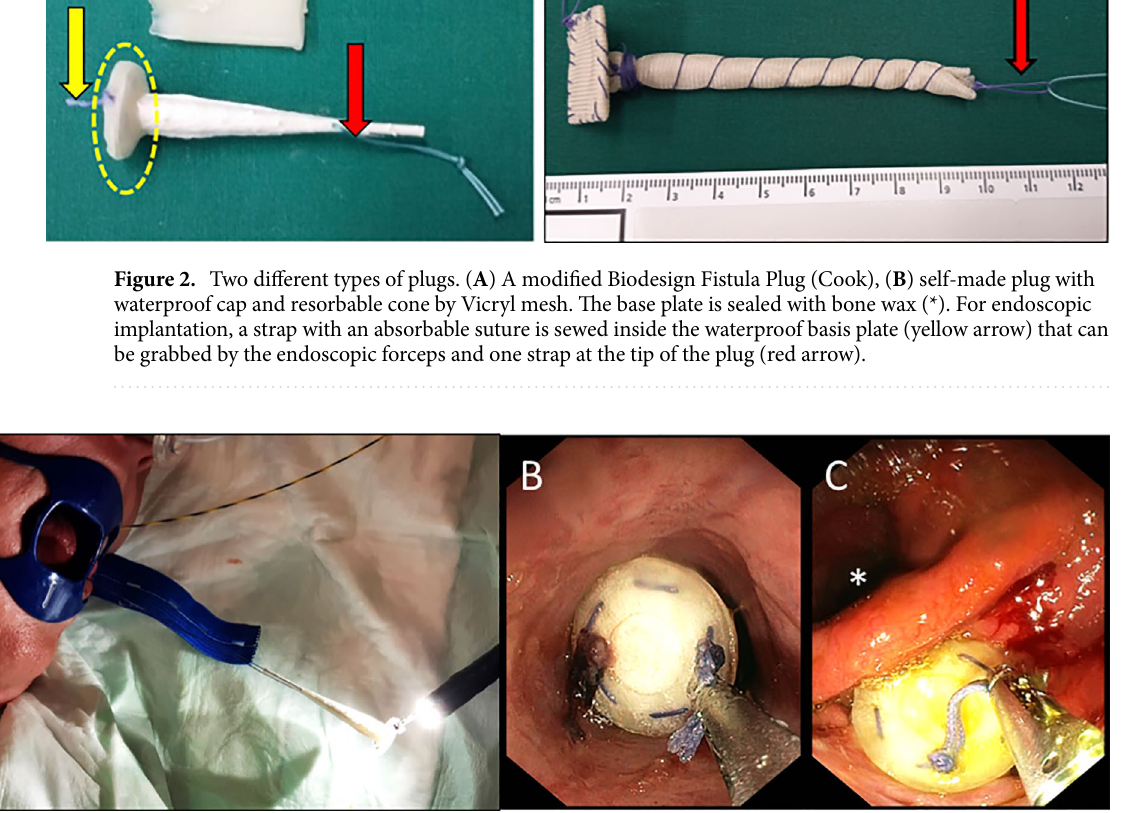
Figure 3. ( A ) The loop at the base plate of the plug is grasped. ( B ) By careful pulling of the suture that is fixated at the tip of the plug and is externalized through the fistula to the skin, ( C ) the plug is placed at the enteric fistula orifice under endoscopic